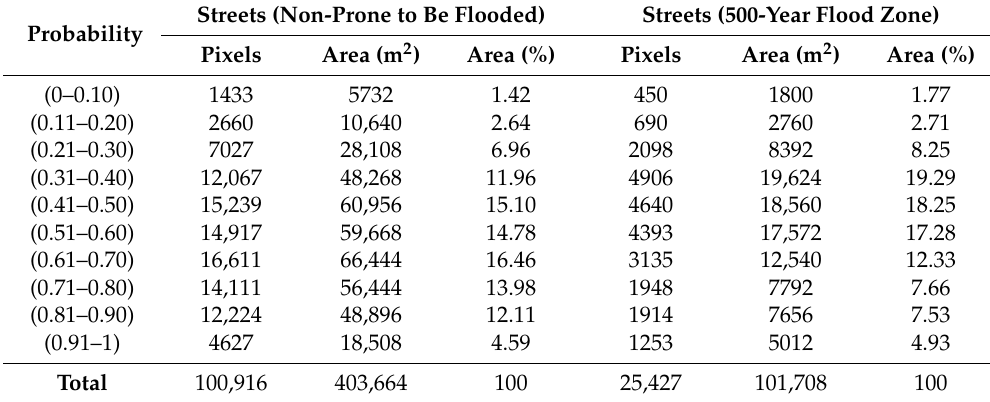
Figure 7. Probability that first floor elevation errors are between − 0.5 m and +0.5 m. Table 1. Area occupied by deciles of probability considering that first floor elevation error is between − 0.5 m and 0.5 m.